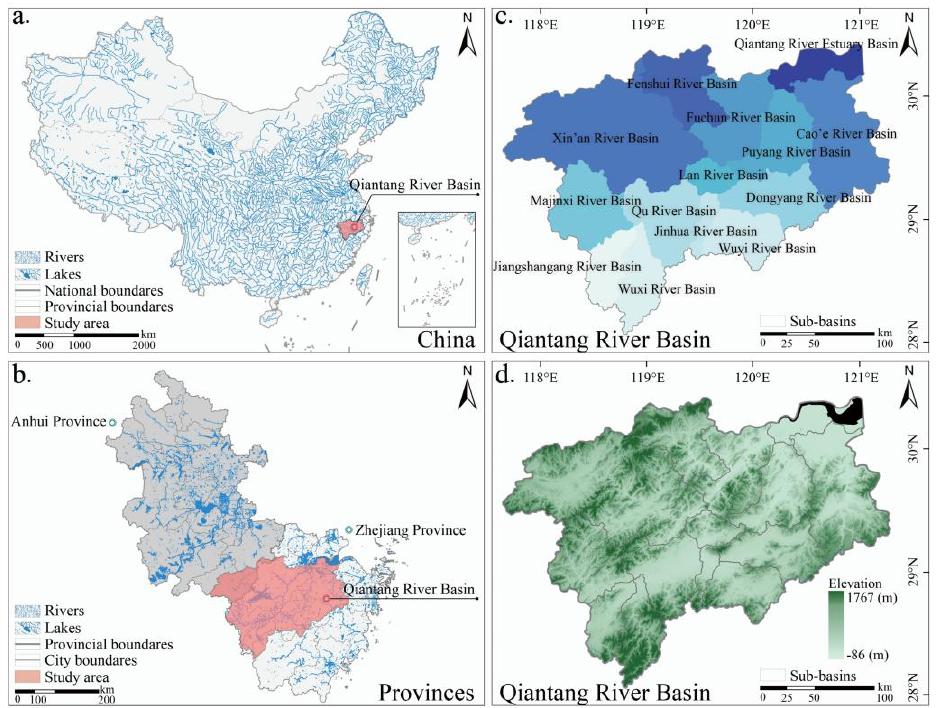
Figure 1. Basic information of the study area: ( a , b ) are the locations of the study area in China and provincial scale; ( c ) is the boundary of 14 sub-basins; and ( d ) is the digital elevation model (DEM) of the study